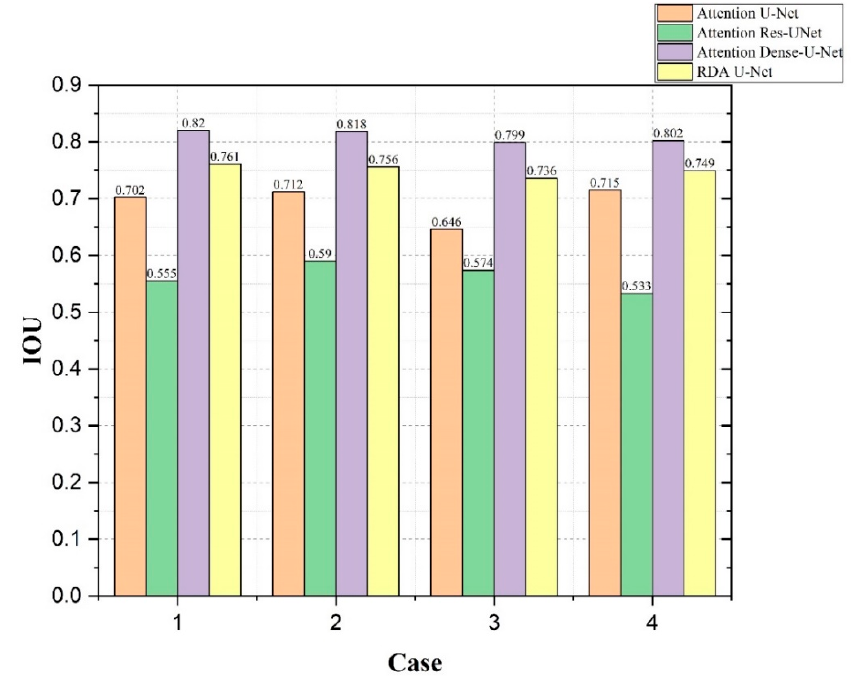
Figure 8. Results of training in 91 patients with mixed LiTS and KCGMH: ( a ) liver and ( b ) lesions.